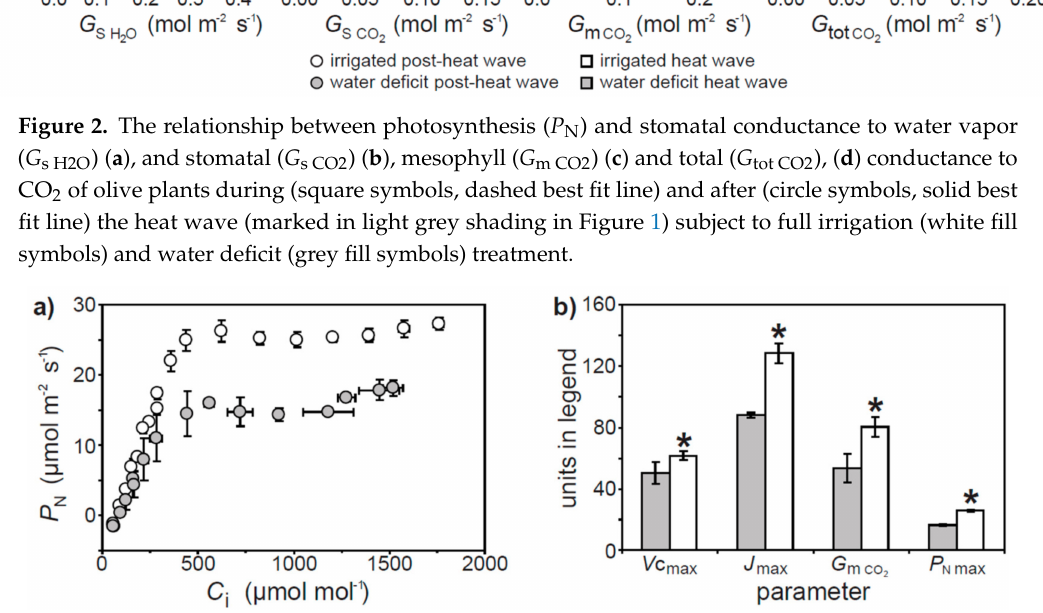
Figure 3. The response of photosynthesis ( P N ) to increasing [CO 2 ] within the internal leaf air-space ( C i ) ( a ) and physiological parameters calculated from the P N - C i response curve utilizing the method of Ethier and Livingston [33] ( b ) in well-watered olive plants during (grey fill symbols) and after (white fill symbols) the heat wave. Y-axis units for V c max , J max , and P N max are µ mol m − 2 s − 1 , and G m CO2 is measured in mmol m − 2 s − 1 . * indicates significant difference between measurements conducted during and after the heat wave using a one-way ANOVA: V c max (F 1,7 = 11.0; P = 0.013), J max (F 1,7 = 199.1; P = 2.1 × 10 − 6 ), G m CO2 (F 1,7 = 7.3; P = 0.031) and P N max (F 1,7 = 151.1; P = 1.8 × 10 − 5 ). Error bars indicate one standard deviation either side of the